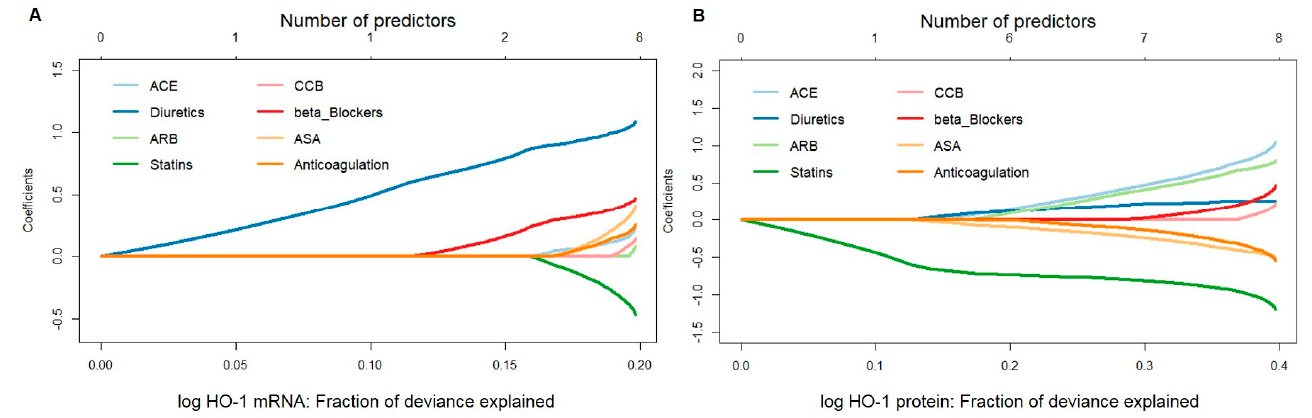
Figure 1. Stepwise model selection using penalized multiple linear regression for HO-1 mRNA and protein expressions in response to different pharmacological therapies in aortic tissues obtained from patients undergoing elective open surgical repair due to AAA. ( A ) mRNA expression was measured by qPCR, and data were normalized to an internal control (=1). ( B ) Protein expression was measured by Western blot, and data were normalized to an internal control (=1). ( A , B ) Data for HO-1 expression were log transformed, and one statistically significant outlier was omitted from the analysis. Data were analyzed by penalized multiple linear regression (elastic net approach), and HO-1 was set as the outcome variable. Predictors were added to a regression model one at a time to maximize the deviance ( X -axis) given the current number of predictors. Regression coefficients, shown on the Y -axis, changed as a new predictor was added to the model and reflected the influence of each predictor depending on other predictors present in the model. Abbreviations: ACE, angiotensin-converting enzyme; ARB, angiotensin II receptor blockers; ASA, acetylsalicylic acid; CCB, calcium channel blockers.